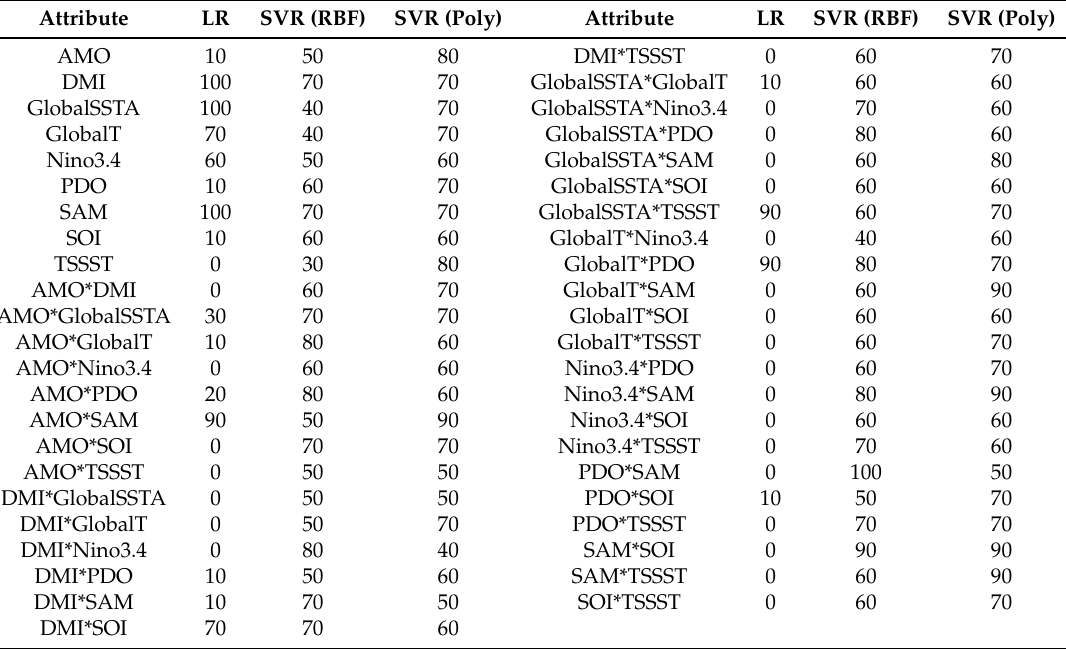
Table 2. Same as Table 1 except for